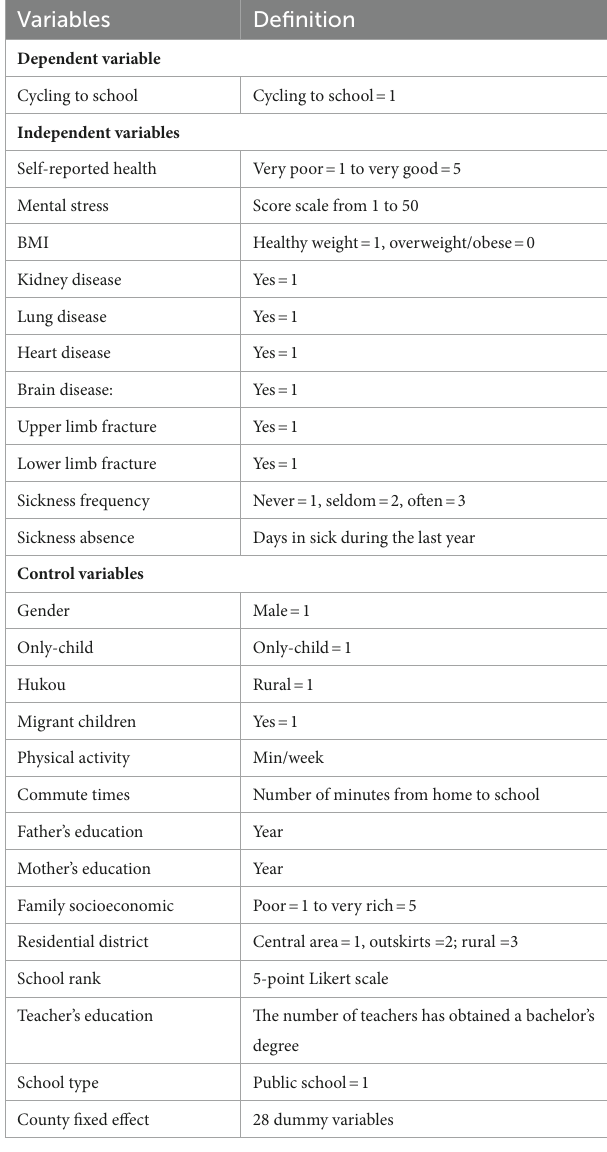
TABLE 1 Description of the